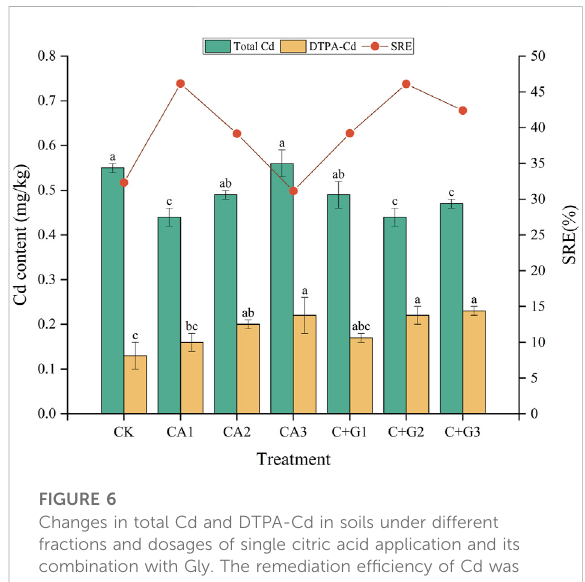
FIGURE 6 Changes in total Cd and DTPA-Cd in soils under different fractions and dosages of single citric acid application and its combination with Gly. The remediation ef fi ciency of Cd was evaluated by calculating the removal rate of Cd in the soil (Different letters indicate signi fi cant differences, p <